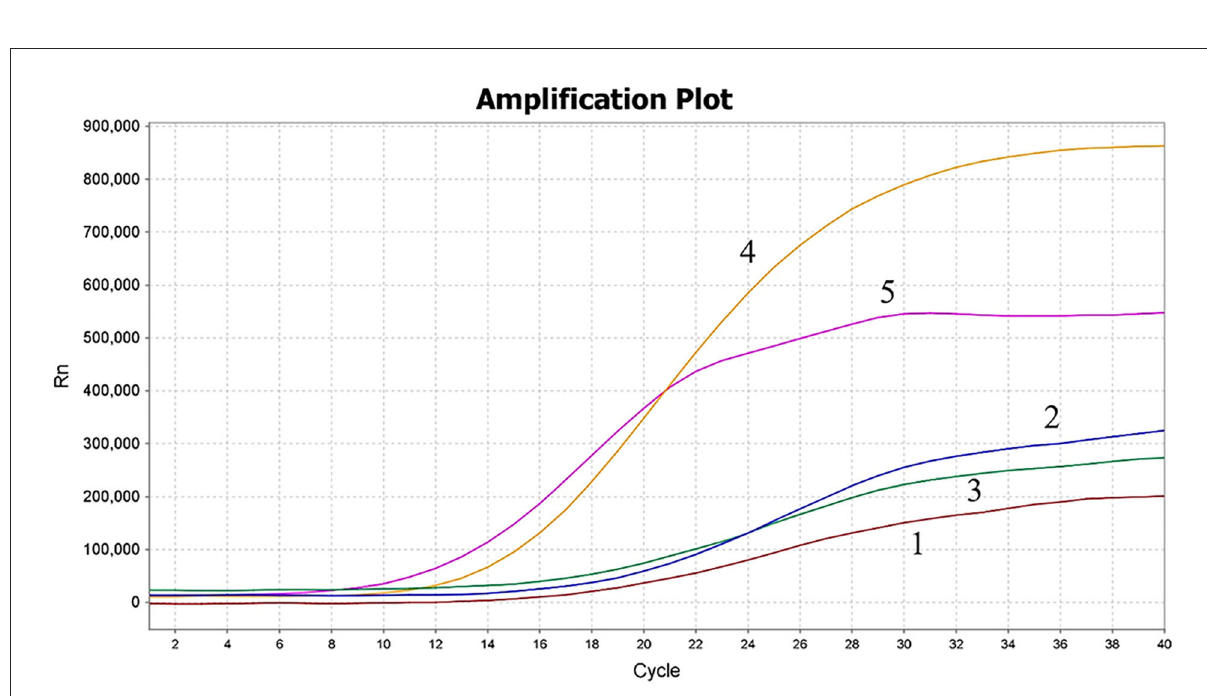
FIGURE3 Screening of MIRA primer pairs. The amplification results of screening five primer pairs. The fifth primer set was used for the MIRA assay. 1–5: the first primer set to the fifth primer set.